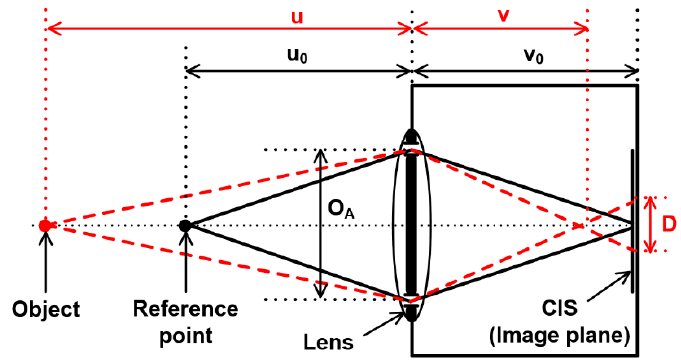
Figure 1. Geometric model for the depth-from-disparity method.